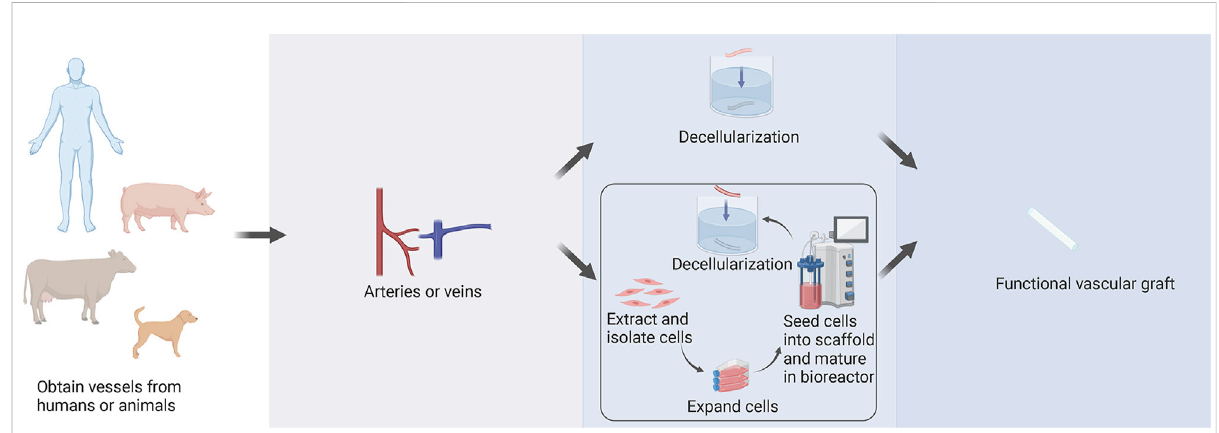
FIGURE 2 Sources of the decellularized vascular matrix. There are two main methods to create the decellularized vascular matrix by obtaining vessels from humans or animals. Vessels are either directly processed by decellularization technologies, or cells can be extracted and isolated from vessels, including smooth muscle cells, fi broblasts, and endothelial cells. With culture and ampli fi cation in vitro , cells are seeded into a degradable polymer scaffold and then matured in a bioreactor. After a period, the scaffold degrades, and the decellularized vascular matrix is obtained by decellularization